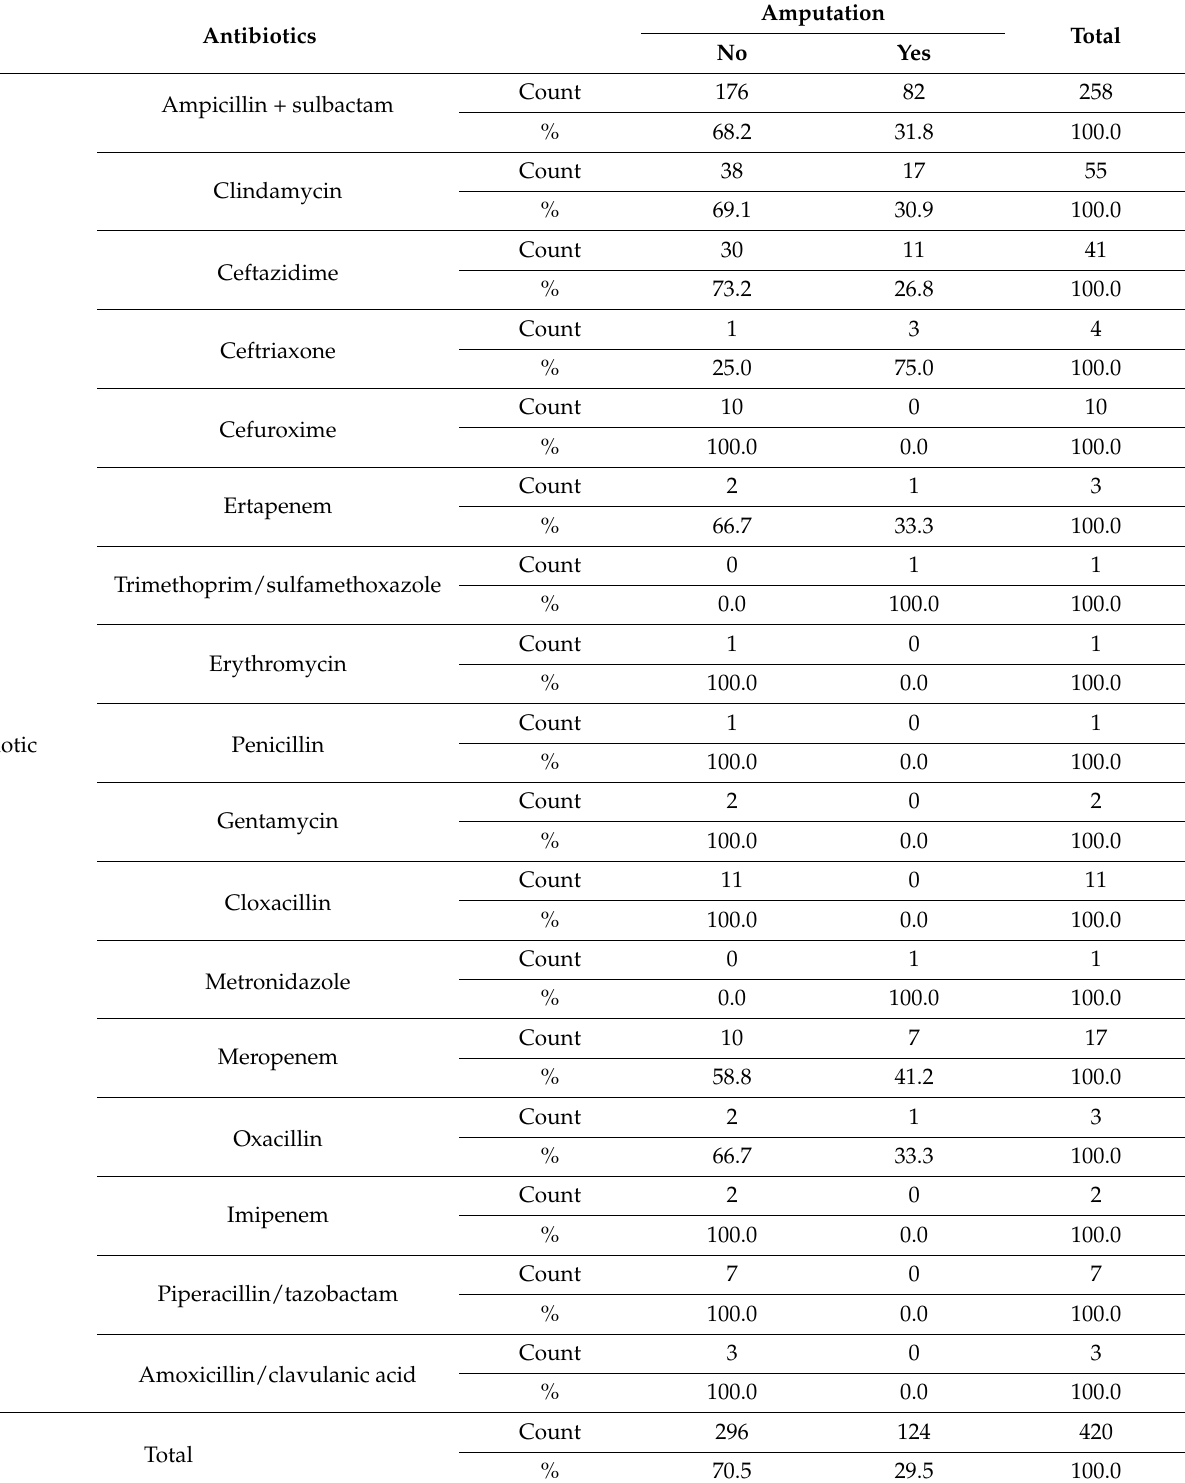
Table 3. Antibiotics and the rate of